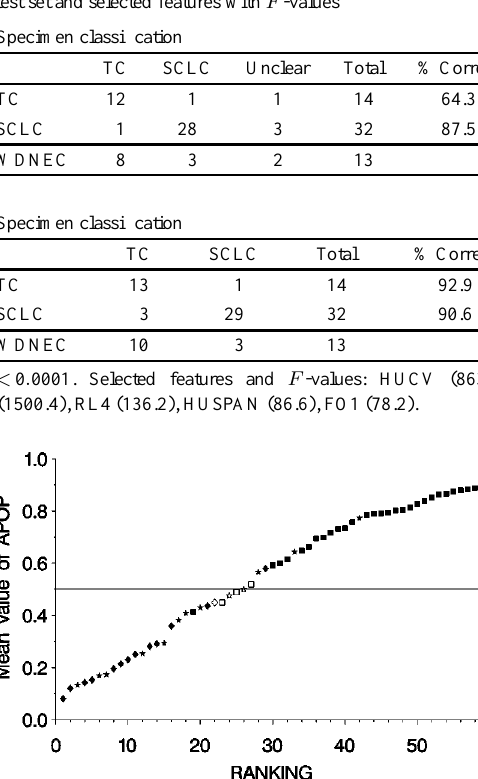
Specimen classification results of TC and SCLC using WDNEC as a test set and selected features with F -values